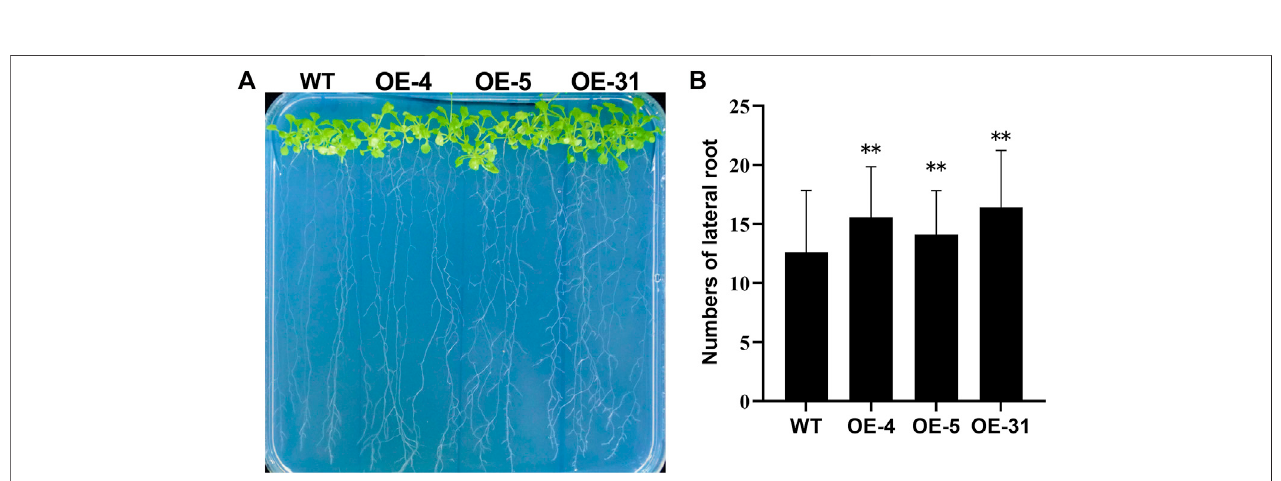
FIGURE 7 | Phenotypic differences in the number of lateral roots between the wild type and OE lines. (A) The lateral root morphology of the OE lines and wild-type seedlings. Eleven day-old seedlings cultured in 1/2 Murashige and Skoog (MS) were observed. (B) The number of lateral roots of the 11-day-old wild type and the OE lines. N = 36 ± SD from three independent biological replicates. The error bars represent the means of three technical replicates ±SD. Statistically signi fi cant differences are indicated as ** p < 0.01.